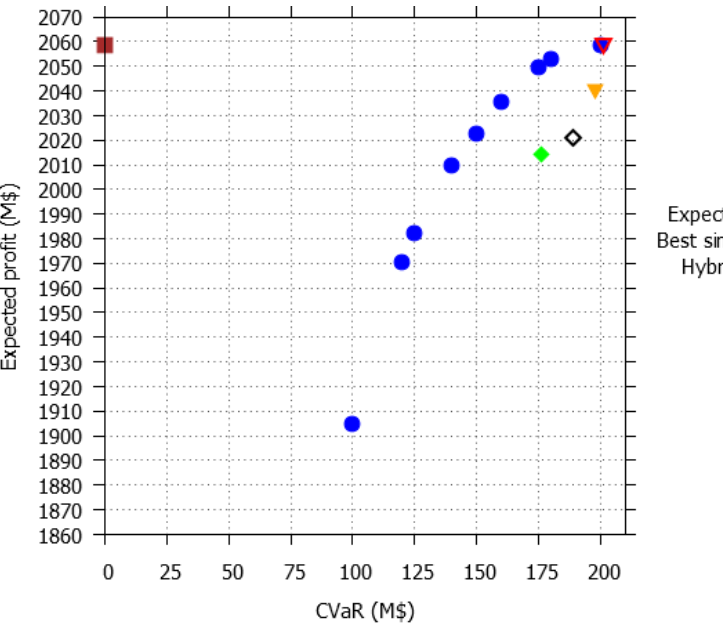
Figure 9. Alternatives of final pits in expected profit vs. risk plane.